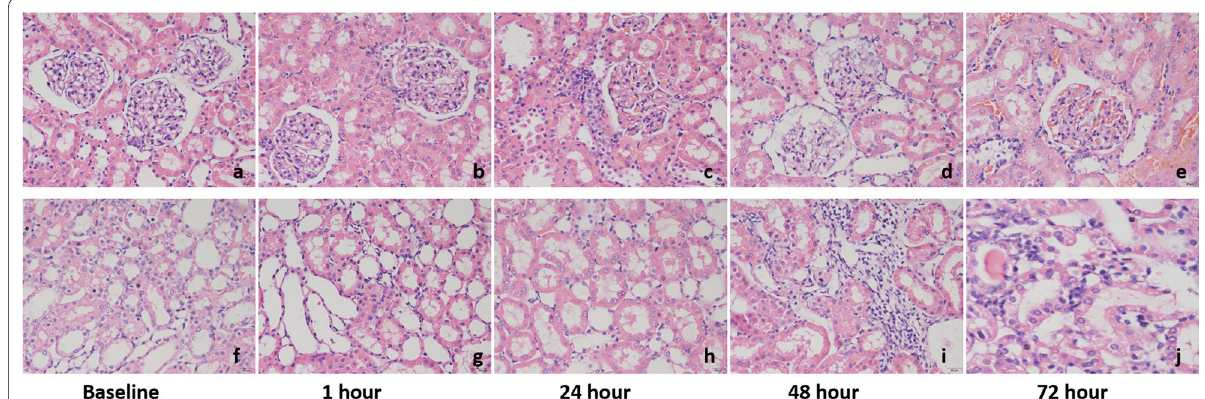
Fig. 5 Pathological images of HE staining of rat kidney at different time points. Representative pathologic images: a , f Diabetic nephropathy rats without contrast injection. b – e , g – j Diabetic nephropathy rats injected with contrast agent ( b , g : 1 h; c , h : 24 h; d , i : 48 h; e , j : 72 h)